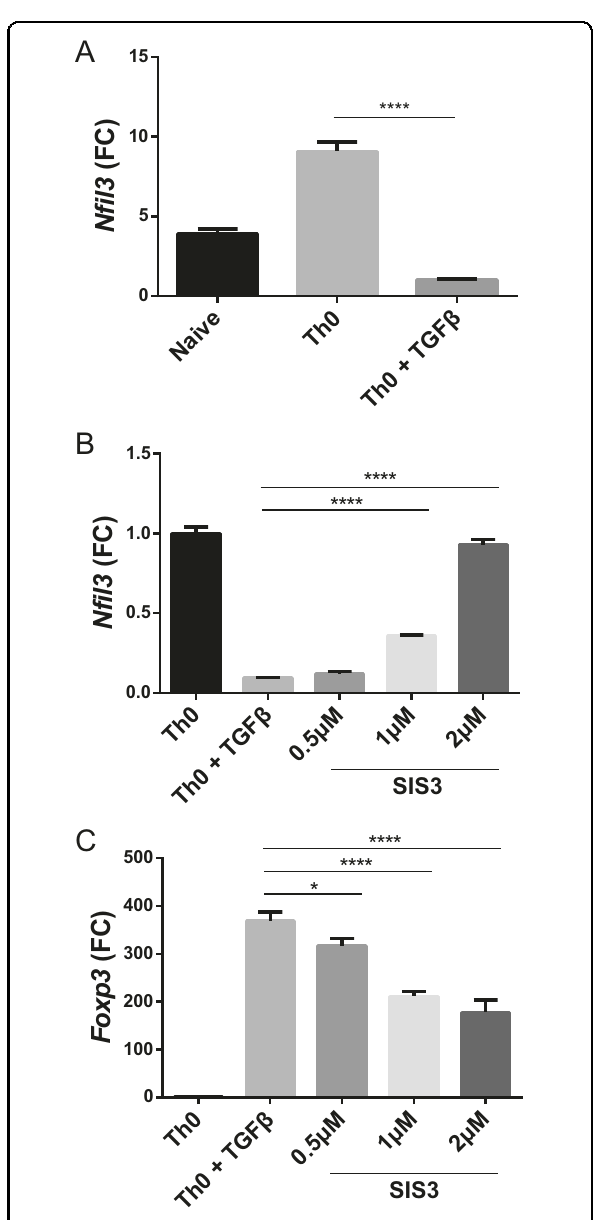
Fig. 2 N fi l3 expression is regulated by the TGF- β / SMAD3 signaling pathway. a N fi l3 mRNA expression levels in naive CD4 T, Th0, and Th0 + TGF- β cells were determined by qRT-PCR. Cells were cultured with plate-bound anti-CD3 and soluble anti-CD28 antibody for 3 days. TGF- β was added at 5 ng/ml. Levels of N fi l3 ( b ) and Foxp3 ( c ) mRNA were measured by qRT-PCR. Cells were cultured with concomitant SIS3 treatment at the indicated concentrations for 3 days. qRT-PCR data are representative of three independent experiments. Error bars represent the SD. The signi fi cance of the differences between groups was determined by Student ’ s t test. * P < 0.05, ** P < 0.01, *** P < 0.001, and **** P < 0.0001, n.s. not signi fi